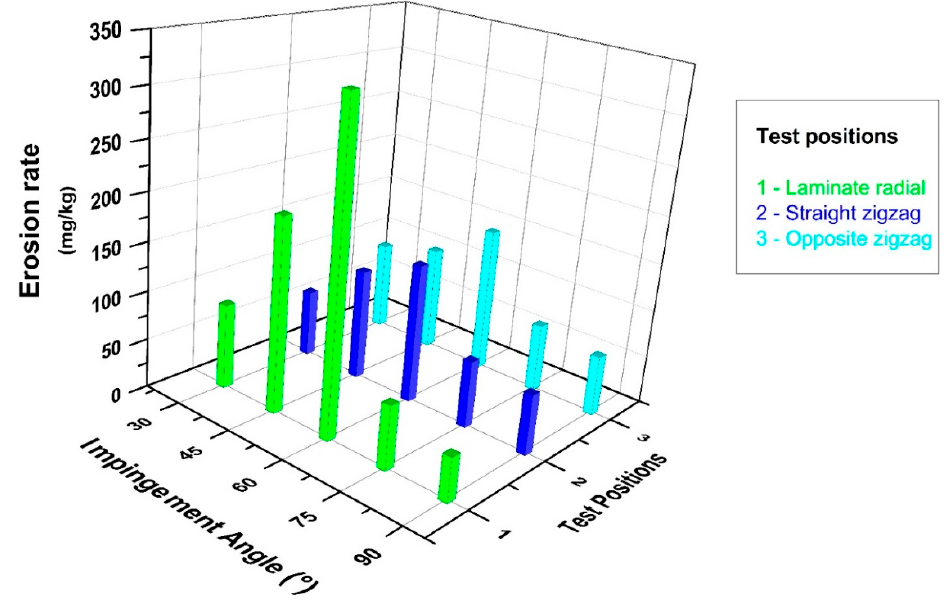
Figure 9. BFR/EP composite pipe outer surface radial orientation erosion rate–impingement angle relationship.